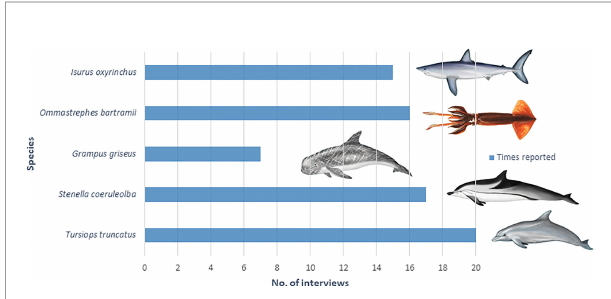
FIGURE 9 | Number of times in which each species was reported to depredate the catch during the interviews (N =